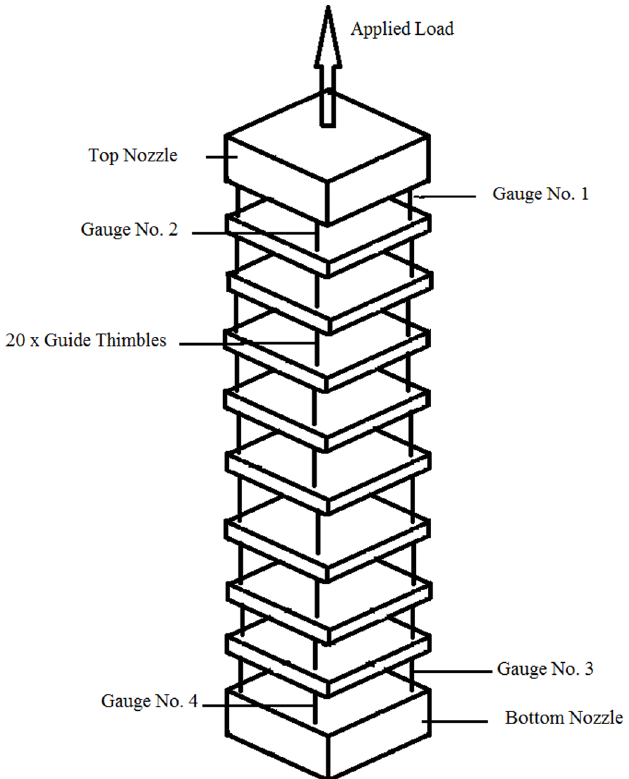
Fig. 5. Strain gauge